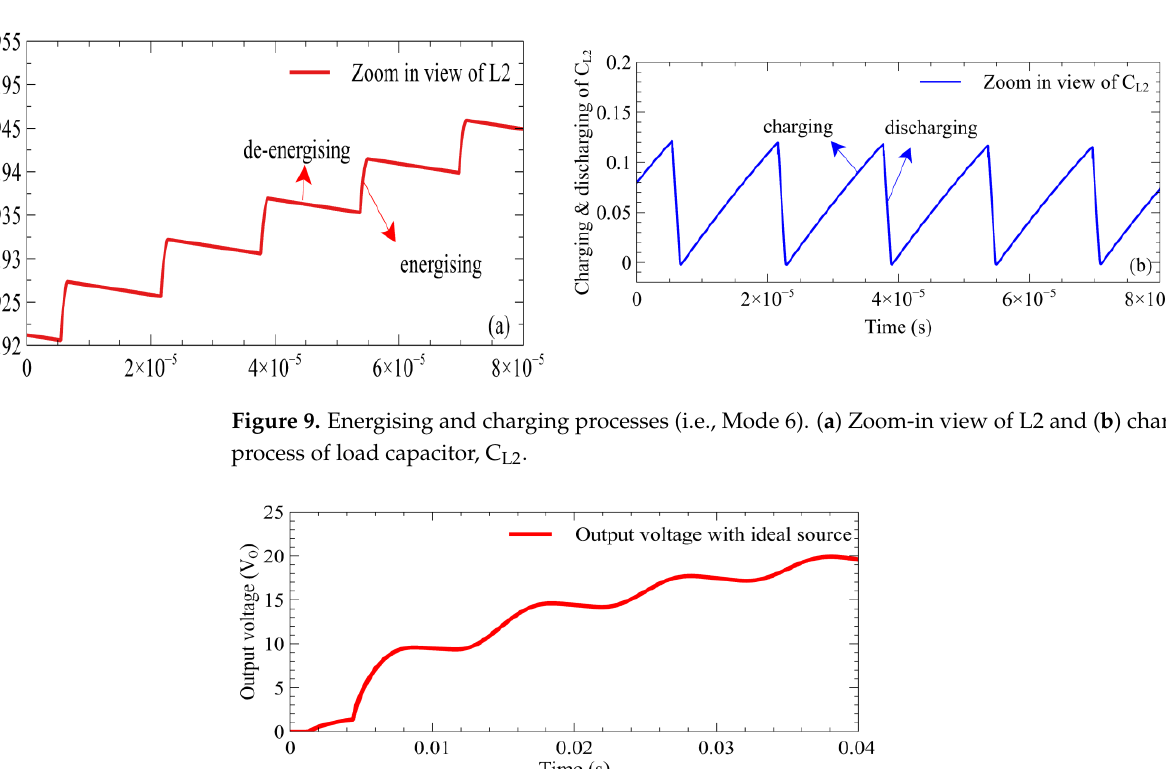
Figure 8. Zoom-in view (i.e., Mode 5) of ( a ) activated switch, Q1, and ( b ) energising secondary winding as a consequence of Q1.